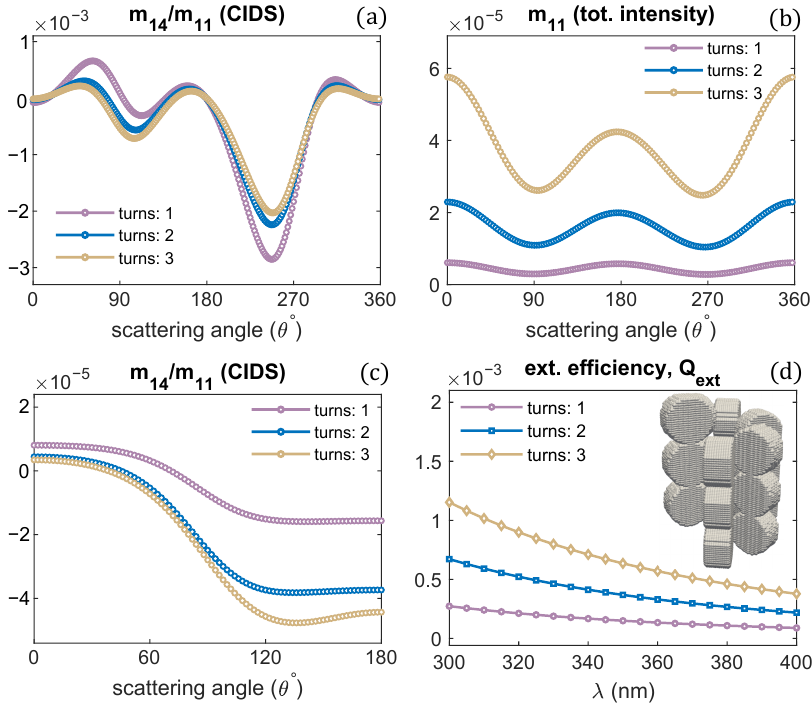
Figure 7. Solenoid helical turns are varied; ( a , b ) angular behavior of scattering quantities at fixed orientation ( α , β , γ ) = ( 0,0,0 ) ; and ( c , d ) in the orientation average. P = 11 nm, R = 10 nm, λ = 300 nm.